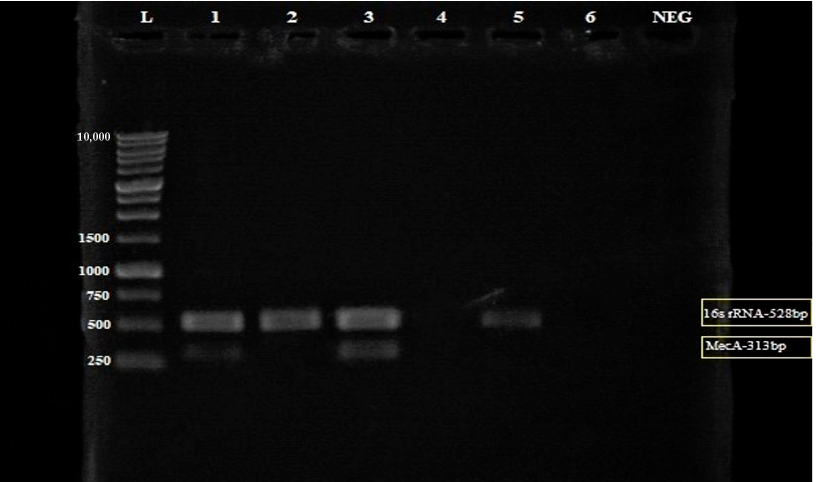
Figure 4. Electrophoresis gel (3% agarose) of the PCR products of the mecA gene and 16S rRNA for the detection of the mecA gene from MRSA (Lane 2–4) and MSSA (Lane 5) isolates. Lane L = 1 kb ladder, Lane 1 = Treated MRSA isolate (in a combination of 1000 μ g/mL PLLME and 1000 μ g/mL ceftriaxone), Lane 2 = Treated MRSA isolate (in a combination of 2000 μ g/mL PLLME and 1000 μ g/mL ceftriaxone), Lane 3 = untreated MRSA isolates, Lane 4 = blank, Lane 5 = MSSA isolate (control), Lane 6 = empty lane and Lane NEG = negative control. The yellow box: The mecA gene was not amplified in MRSA treated with the combination of 2000 μ g/mL PLLME and 1000 μ g/mL ceftriaxone.